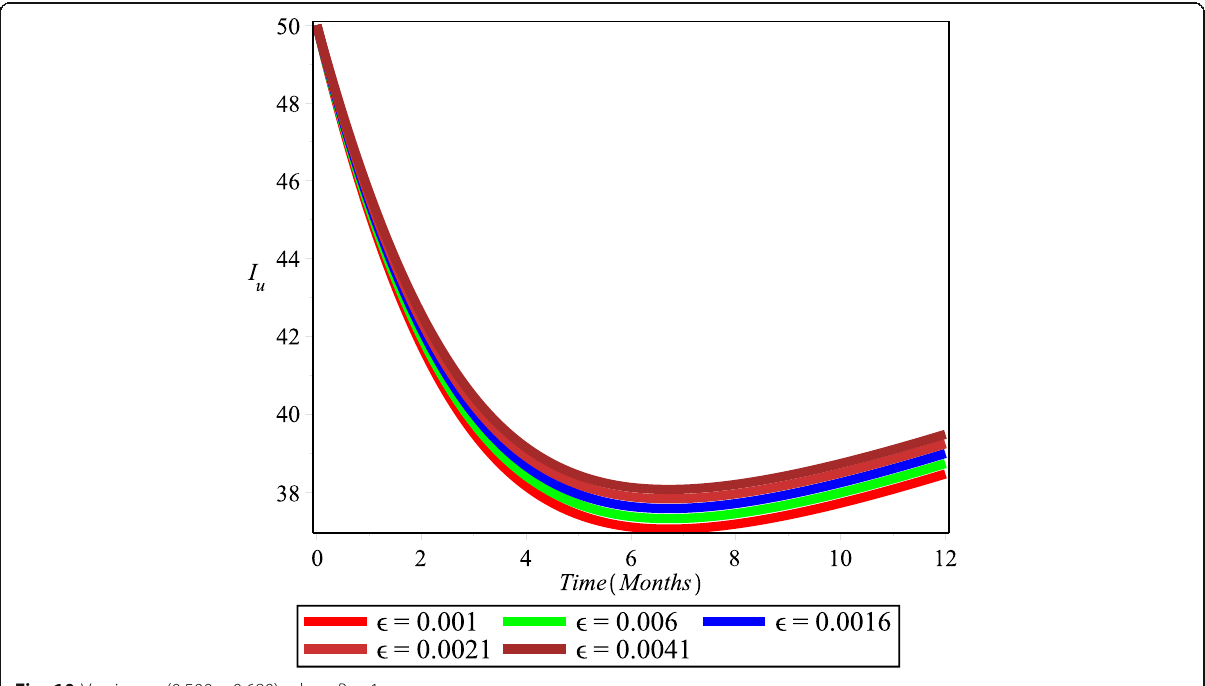
Fig. 10 Varying ϕ 2 (0.500 − 0.680) when R r > 1